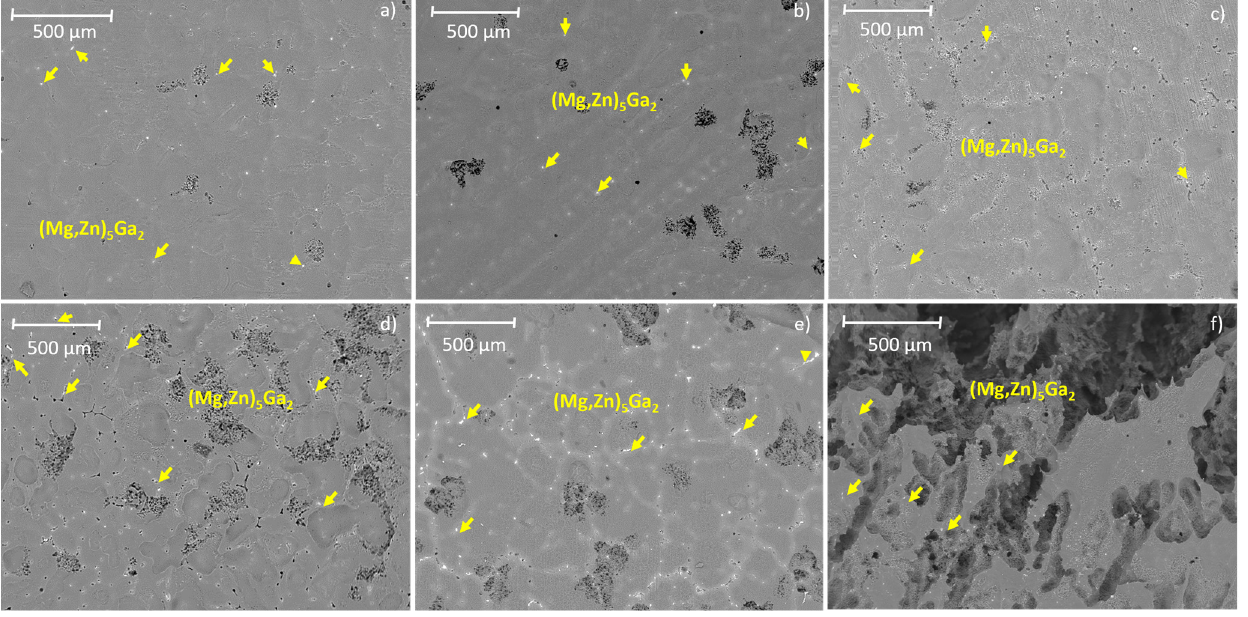
Figure 6. SEM images of as-cast ( a ) Mg-0.38Ga-1.5Zn, ( b ) Mg-1.12Ga-1.5Zn, ( c ) Mg-0.75Ga-3Zn, ( d ) Mg-0.38Ga-4.5Zn, ( e ) Mg-1.12Ga-4.5Zn and ( f ) Mg-1.5Ga-6Zn alloys after 168 h of immersion in SBF